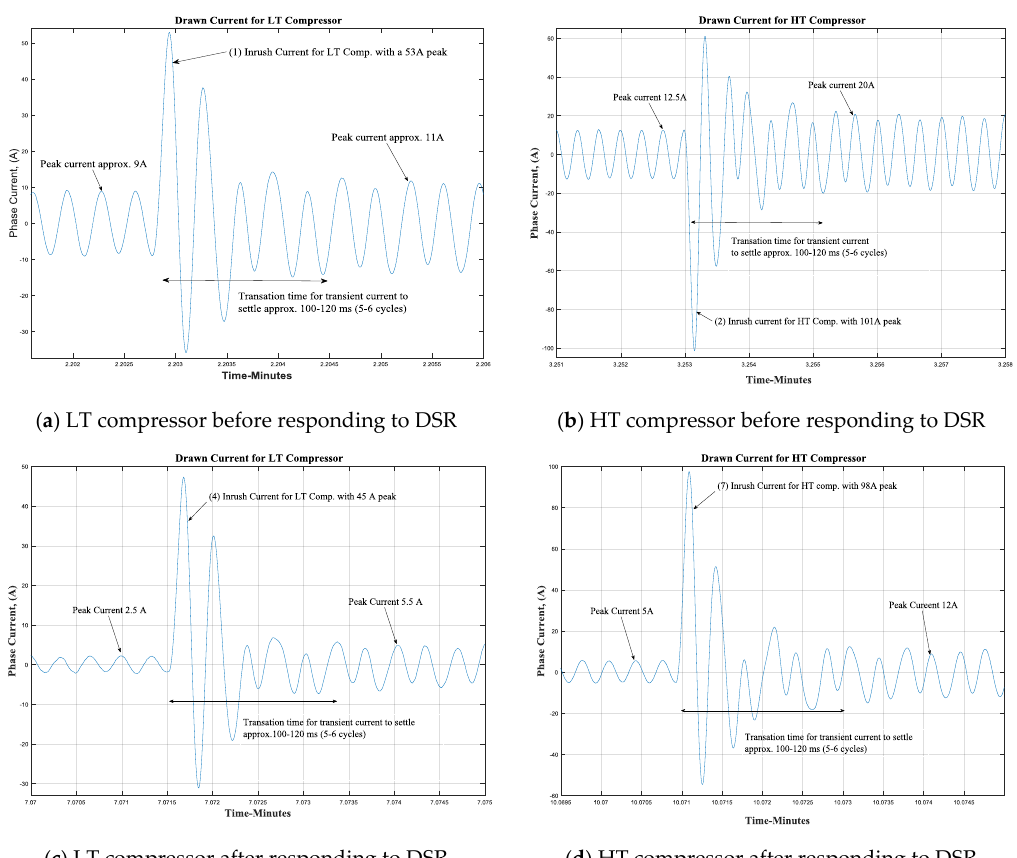
Figure 12. One phase inrush currents of the HT and LT compressor operation before and after DSR.